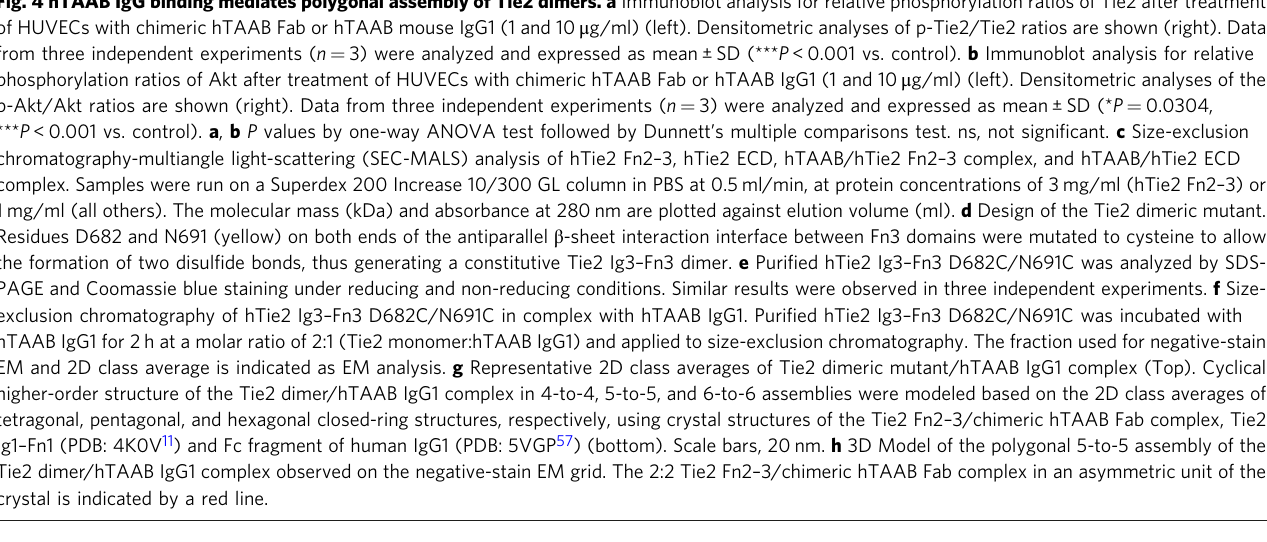
Fig. 4 hTAAB IgG binding mediates polygonal assembly of Tie2 dimers. a Immunoblot analysis for relative phosphorylation ratios of Tie2 after treatment of HUVECs with chimeric hTAAB Fab or hTAAB mouse IgG1 (1 and 10 μ g/ml) (left). Densitometric analyses of p-Tie2/Tie2 ratios are shown (right). Data from three independent experiments ( n = 3) were analyzed and expressed as mean ± SD (*** P < 0.001 vs. control). b Immunoblot analysis for relative phosphorylation ratios of Akt after treatment of HUVECs with chimeric hTAAB Fab or hTAAB IgG1 (1 and 10 μ g/ml) (left). Densitometric analyses of the p-Akt/Akt ratios are shown (right). Data from three independent experiments ( n = 3) were analyzed and expressed as mean ± SD (* P = 0.0304, *** P < 0.001 vs. control). a , b P values by one-way ANOVA test followed by Dunnett ’ s multiple comparisons test. ns, not signi fi cant. c Size-exclusion chromatography-multiangle light-scattering (SEC-MALS) analysis of hTie2 Fn2 – 3, hTie2 ECD, hTAAB/hTie2 Fn2 – 3 complex, and hTAAB/hTie2 ECD complex. Samples were run on a Superdex 200 Increase 10/300 GL column in PBS at 0.5 ml/min, at protein concentrations of 3 mg/ml (hTie2 Fn2 – 3) or 1 mg/ml (all others). The molecular mass (kDa) and absorbance at 280 nm are plotted against elution volume (ml). d Design of the Tie2 dimeric mutant. Residues D682 and N691 (yellow) on both ends of the antiparallel β -sheet interaction interface between Fn3 domains were mutated to cysteine to allow the formation of two disul fi de bonds, thus generating a constitutive Tie2 Ig3 – Fn3 dimer. e Puri fi ed hTie2 Ig3 – Fn3 D682C/N691C was analyzed by SDS- PAGE and Coomassie blue staining under reducing and non-reducing conditions. Similar results were observed in three independent experiments. f Size- exclusion chromatography of hTie2 Ig3 – Fn3 D682C/N691C in complex with hTAAB IgG1. Puri fi ed hTie2 Ig3 – Fn3 D682C/N691C was incubated with hTAAB IgG1 for 2 h at a molar ratio of 2:1 (Tie2 monomer:hTAAB IgG1) and applied to size-exclusion chromatography. The fraction used for negative-stain EM and 2D class average is indicated as EM analysis. g Representative 2D class averages of Tie2 dimeric mutant/hTAAB IgG1 complex (Top). Cyclical higher-order structure of the Tie2 dimer/hTAAB IgG1 complex in 4-to-4, 5-to-5, and 6-to-6 assemblies were modeled based on the 2D class averages of tetragonal, pentagonal, and hexagonal closed-ring structures, respectively, using crystal structures of the Tie2 Fn2 – 3/chimeric hTAAB Fab complex, Tie2 Ig1 – Fn1 (PDB: 4K0V 11 ) and Fc fragment of human IgG1 (PDB: 5VGP 57 ) (bottom). Scale bars, 20 nm. h 3D Model of the polygonal 5-to-5 assembly of the Tie2 dimer/hTAAB IgG1 complex observed on the negative-stain EM grid. The 2:2 Tie2 Fn2 – 3/chimeric hTAAB Fab complex in an asymmetric unit of the crystal is indicated by a red